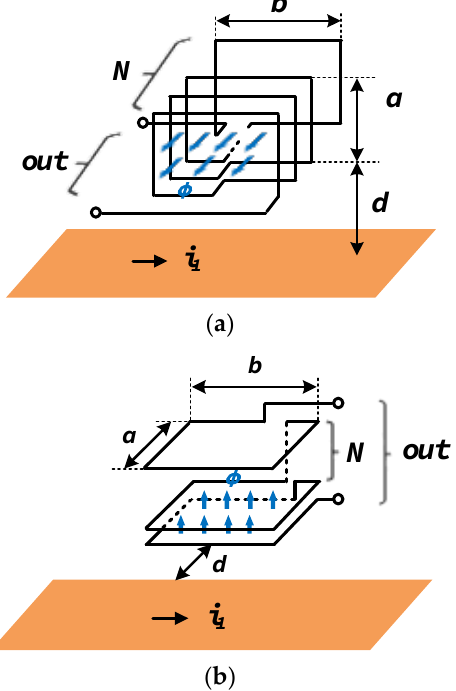
Figure 10. Geometry of the pickup coil with N-turns: ( a ) vertical structure and ( b ) horizontal structure.